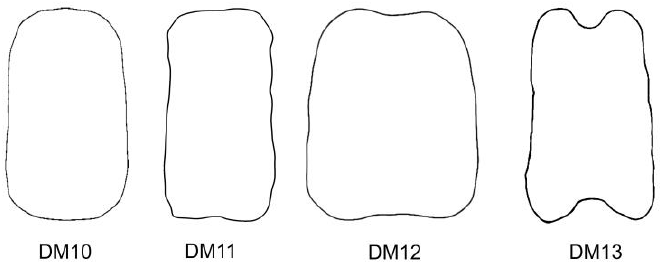
Figure 4. New dorsal models described in this work through the application of Fourier transform to average silhouettes as described